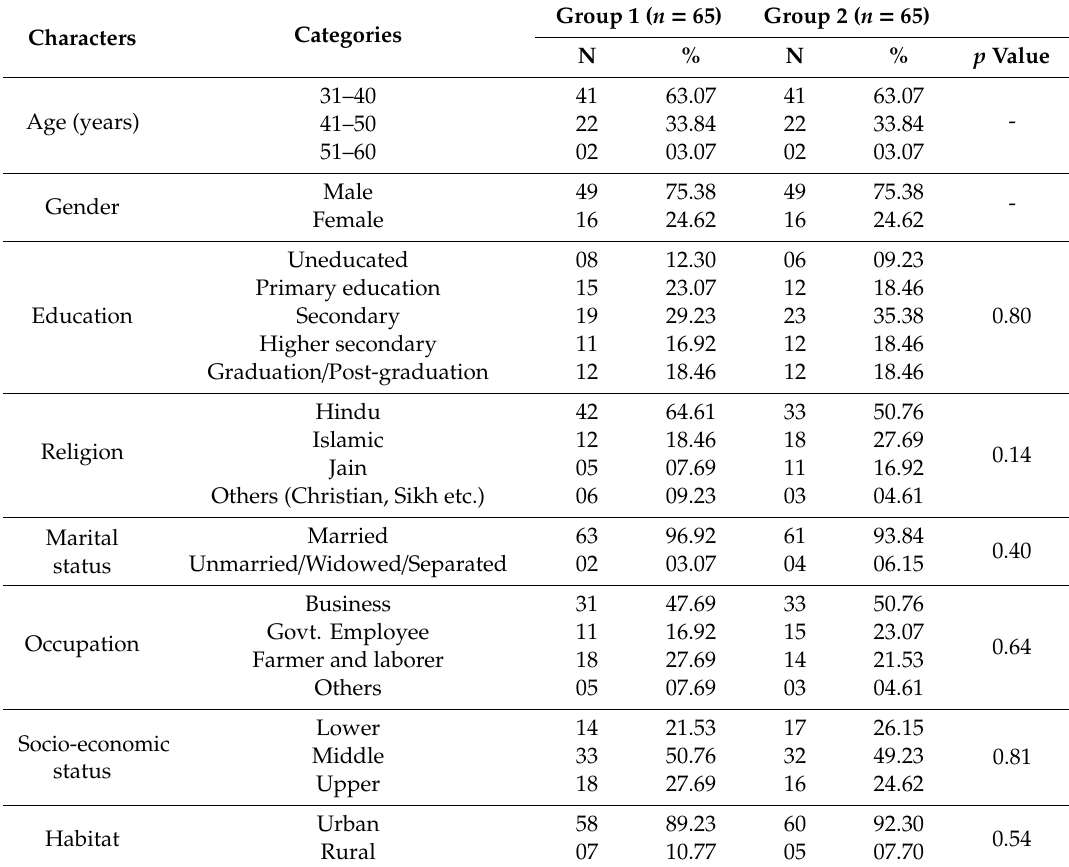
Table 1. Socio and demographic background did not di ff er between both groups. Table 1. Baseline